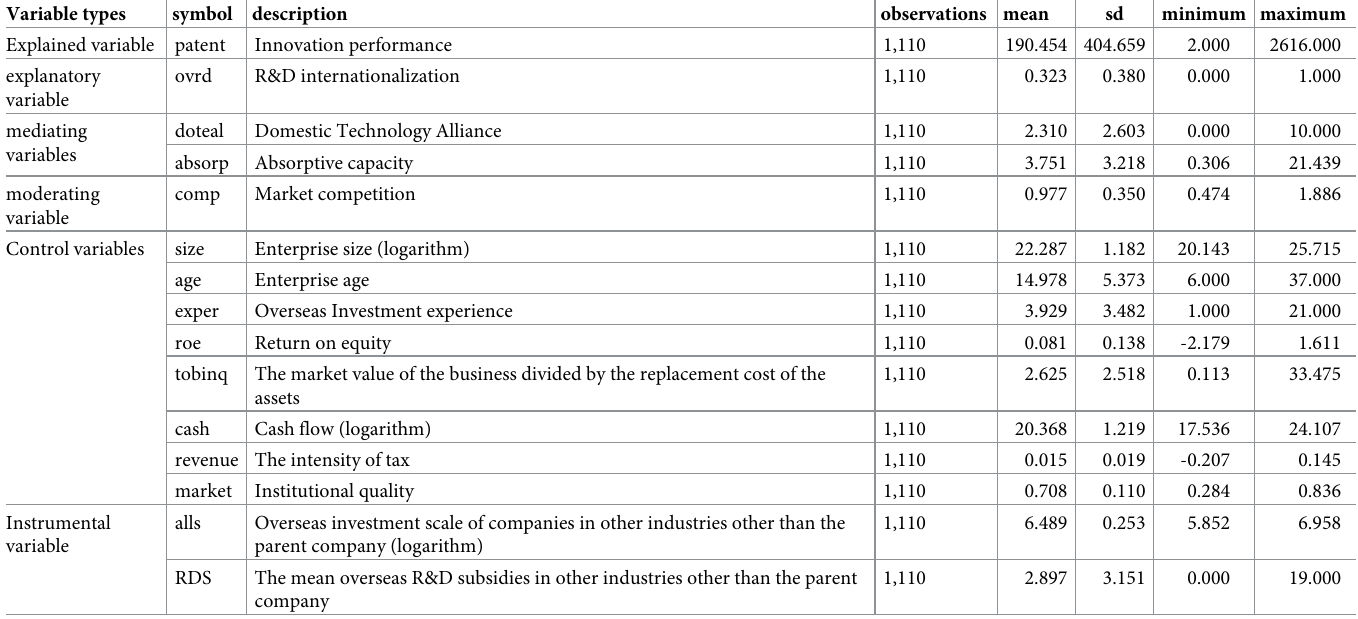
Table 1. Variable source and definition table.